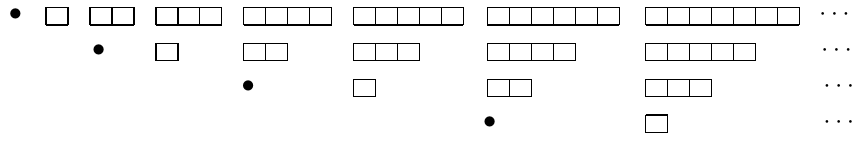
Figure 6 . The so (2 ; 1)-covariant basis of the universal enveloping algebra U